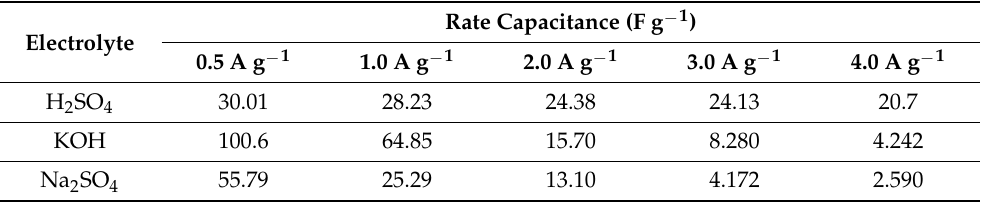
Table 2. Rate capacitance obtained by CB/CA in different 1.0 mol L − 1 electrolytes and current densities.